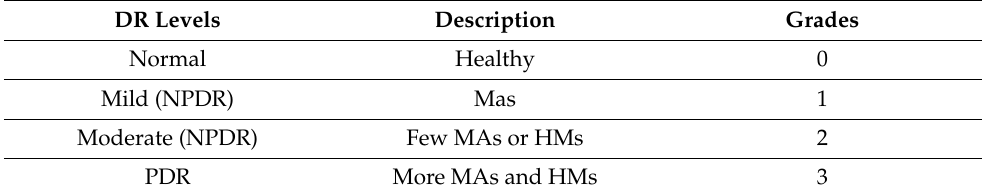
Table 3. Classification dataset description.